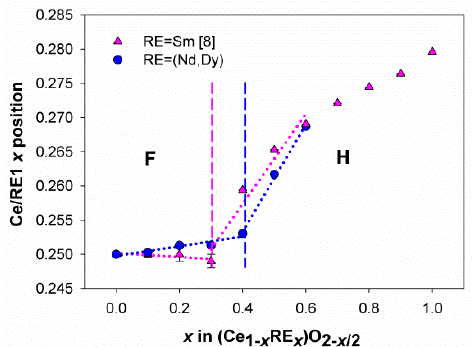
Figure 4. Trend of the RE1 x position in the Nd/Dy- and Sm-doped systems. Data of Sm are taken from Reference [8]. Error bars are sometimes hidden by data markers. Dotted lines are regression lines fitting data within the F and the H region. The vertical dashed lines approximately indicate the position of the F/H transition.